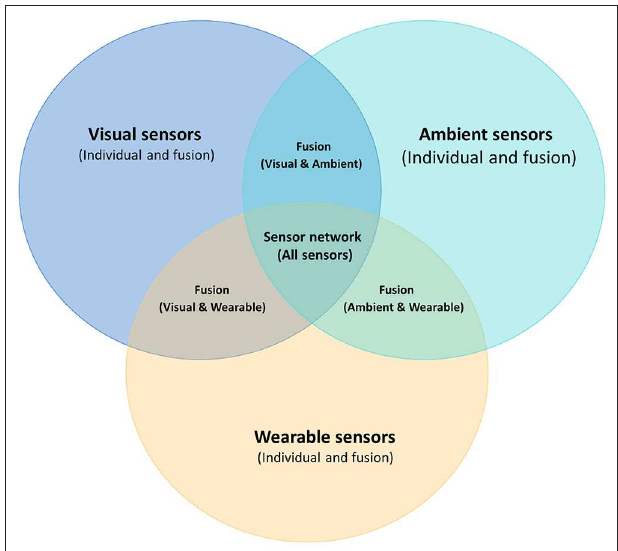
FIGURE 6 | Different kinds of individual sensors and sensor networks, including vision-based, wearable, and ambient sensors, along with sensor